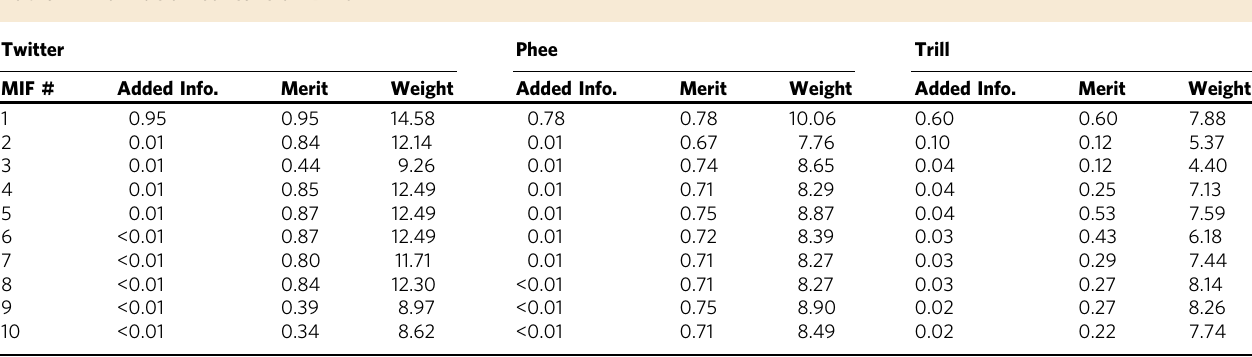
accomplished using 11 MIFs for twitter vs. all other calls, 20 MIFs for trill vs. all other calls, and 16 for phee vs. all other calls. In Fig. 3, magenta boxes outline the top 5 MIFs that are optimal for each of these classi fi cation tasks (the fi rst fi ve MIFs in Table 1).